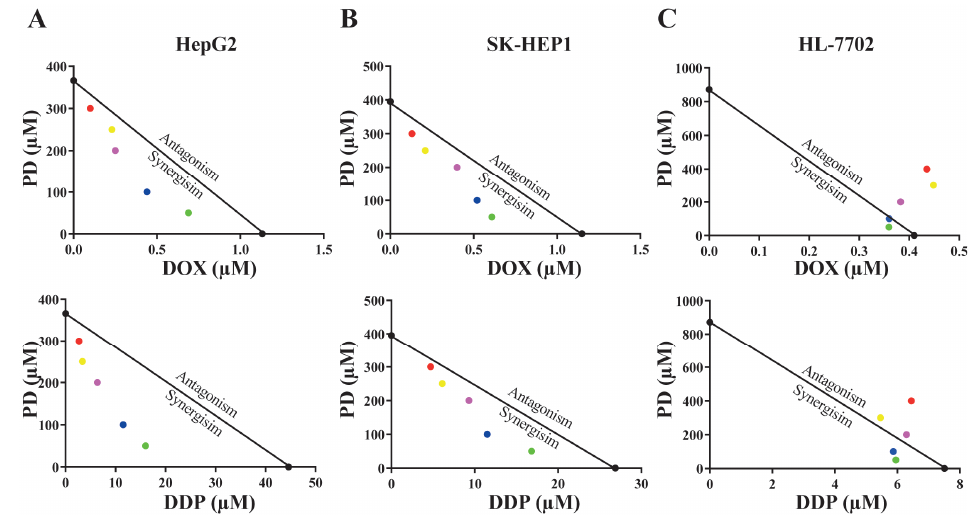
Figure 2. Isobologram analyses of anti ‐ cancer activity of PD and DOX or DDP combinations in HepG2 ( A ), SK ‐ HEP1 ( B ) and HL ‐ 7702 ( C ) cell lines using IC 50 values. The color dots represent various drug concentrations of PD (300 μ M ‐ red; 250 μ M ‐ yellow; 200 μ M ‐ purple; 100 μ M ‐ blue; and 50 μ M ‐ green).